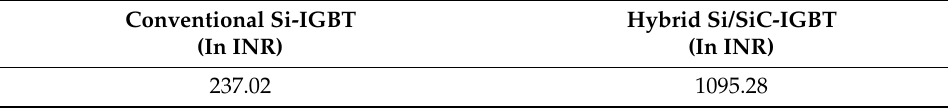
Figure 16. B 10 lifetime comparison chart. Figure 16. B10 lifetime comparison chart. Table 2. Cost